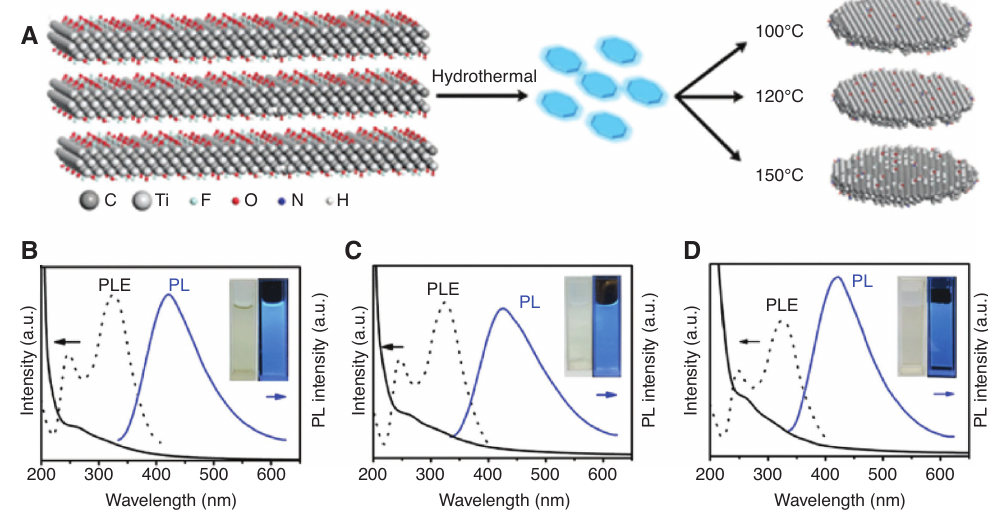
Figure 6: The preparation diagram of MQDs and the intensities over UV-vis spectra, PLE, and PL spectra for MODs in aqueous solutions at different